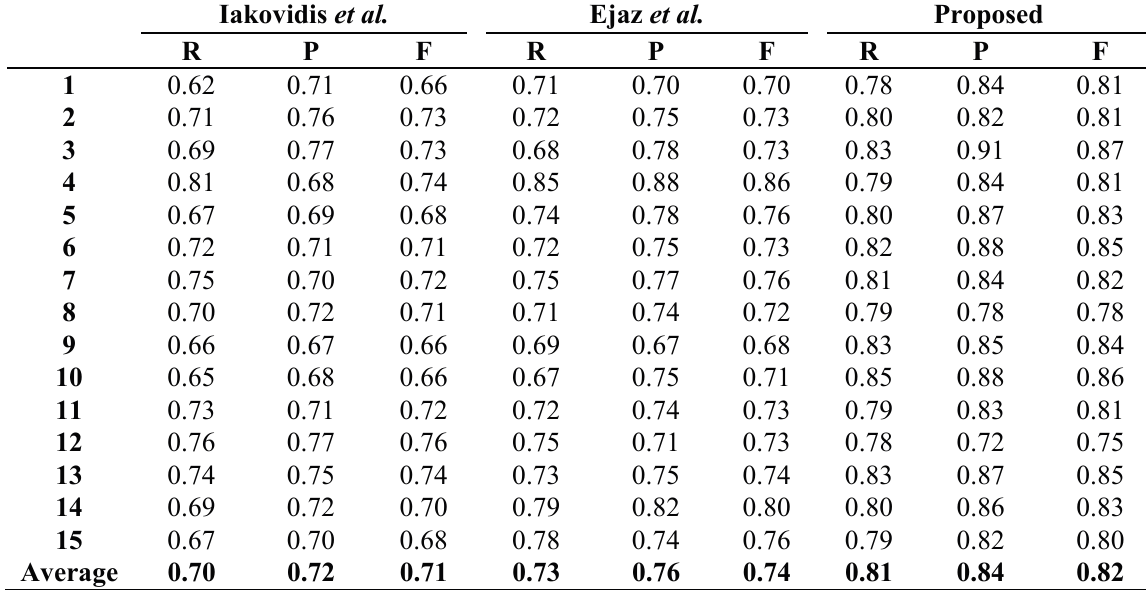
Table 4. Recall (R), Precision (P), and F-Measure (F) scores for different techniques. Iakovidis et al. Ejaz et al.